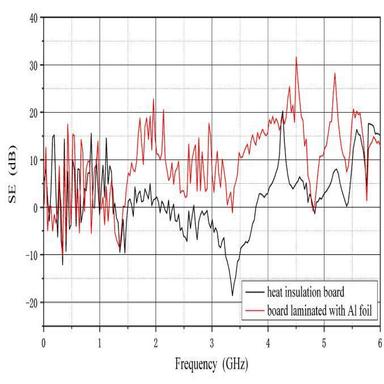
SE test of a 3 mm heat insulation board laminated with aluminum foil. Fig. 13. Comparison of SE for heat insulation board samples with or without laminated aluminum foil.